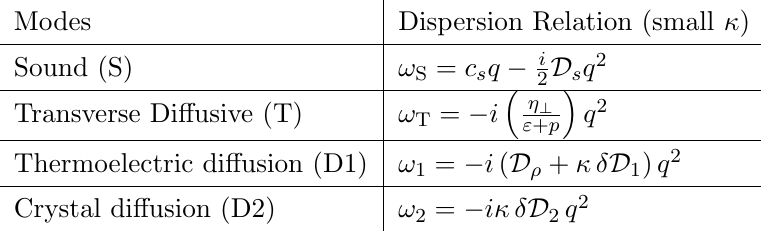
Table 1 . A table summarizing the low energy modes in the spontaneous symmetry broken